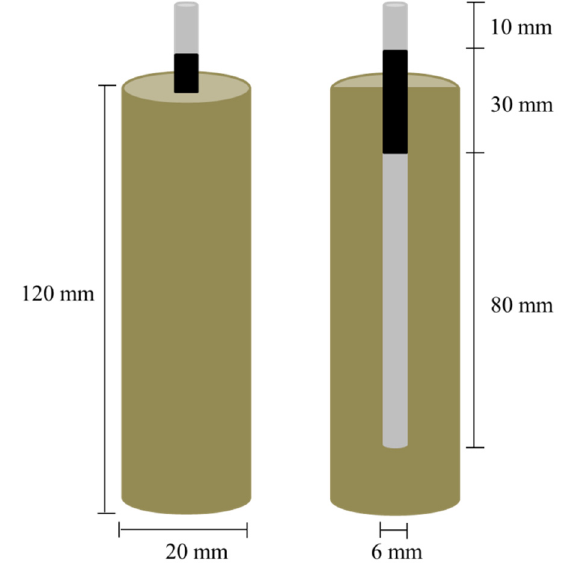
Figure 17. Schematic illustration of the test set up for electrochemical investigations.